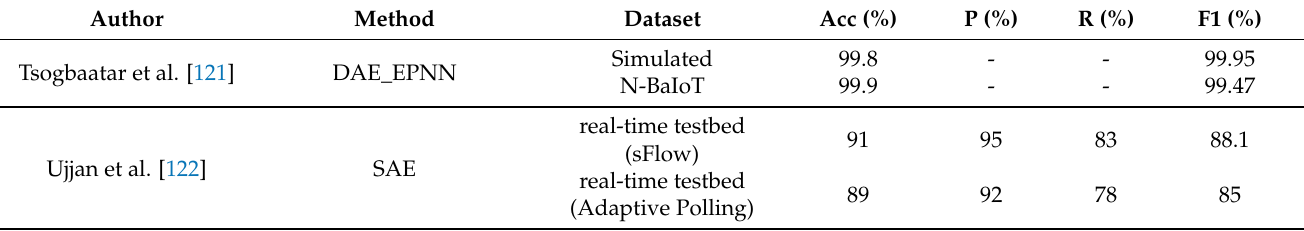
Table 8. Summary of BotNet attack Detection using Deep Autoencoder in an SDN-enabled IoT